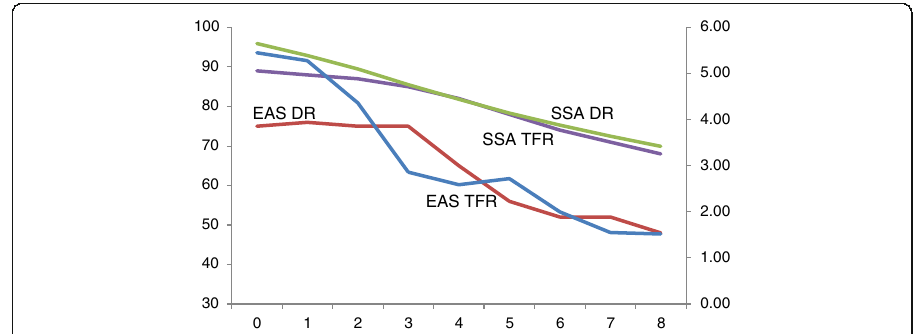
Fig. 1 Total fertility rate and dependency rate, sub-Saharan Africa and East Asia, 5-year periods from start of fertility transition, 1960 for EAS, 2000 for SSA. Note: Left-hand axis is total dependency rate (DR); right-hand axis is total fertility rate (TFR); horizontal axis is number of 5-year period after the start of the fertility transition. Source: United Nations World Population Prospects: The 2012 Revision